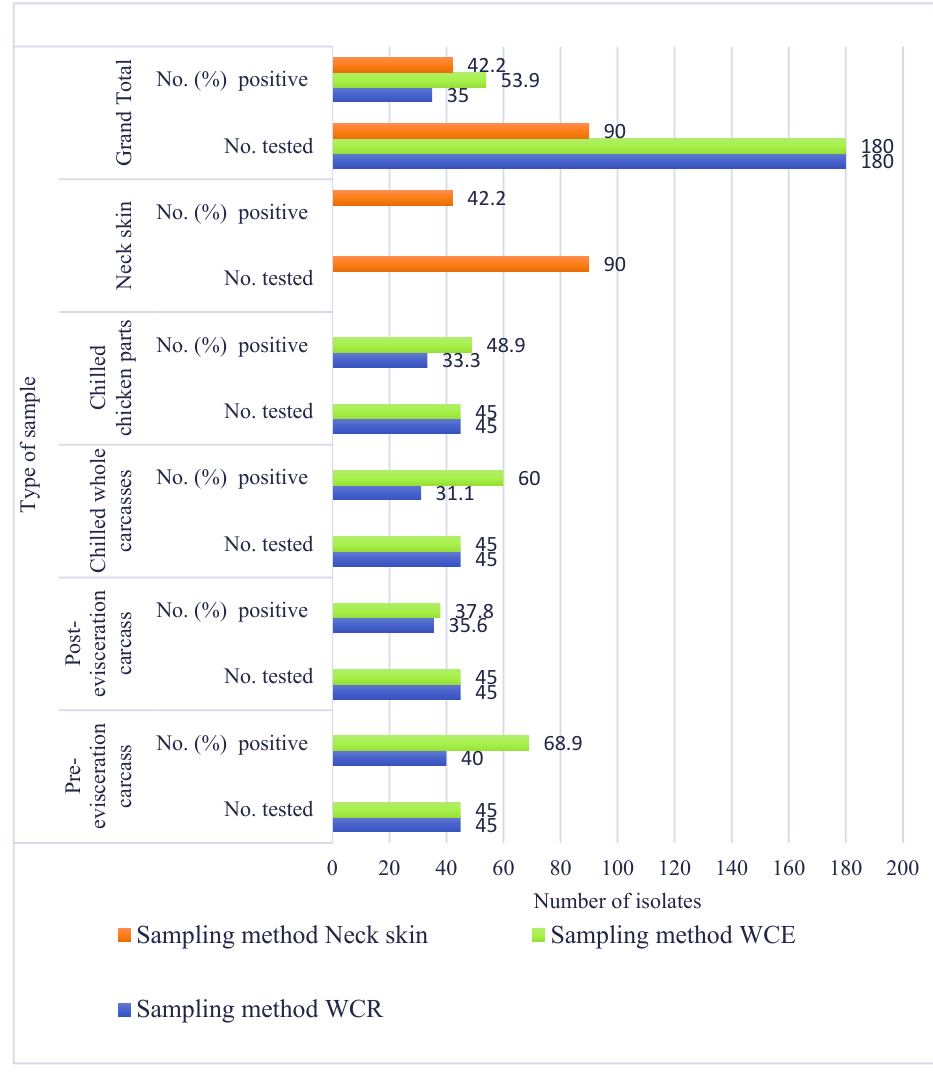
Figure 1. Recovery of Salmonella based on the method used.